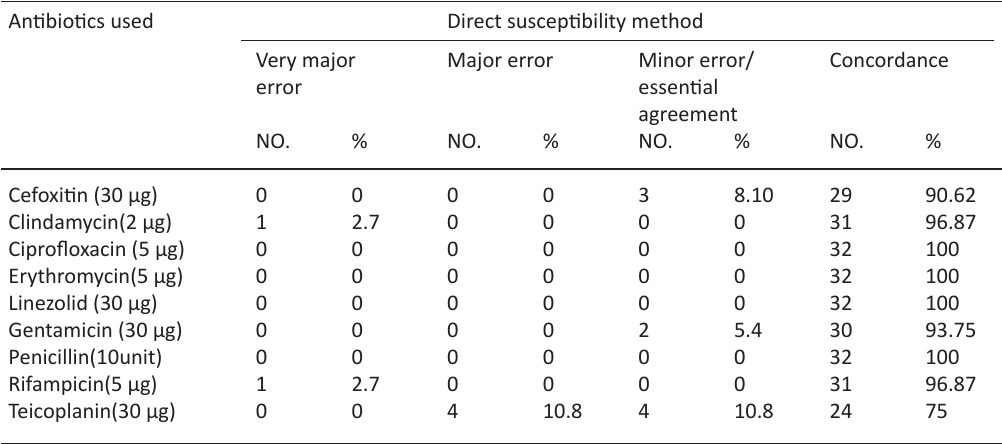
Penicillin(10unit)